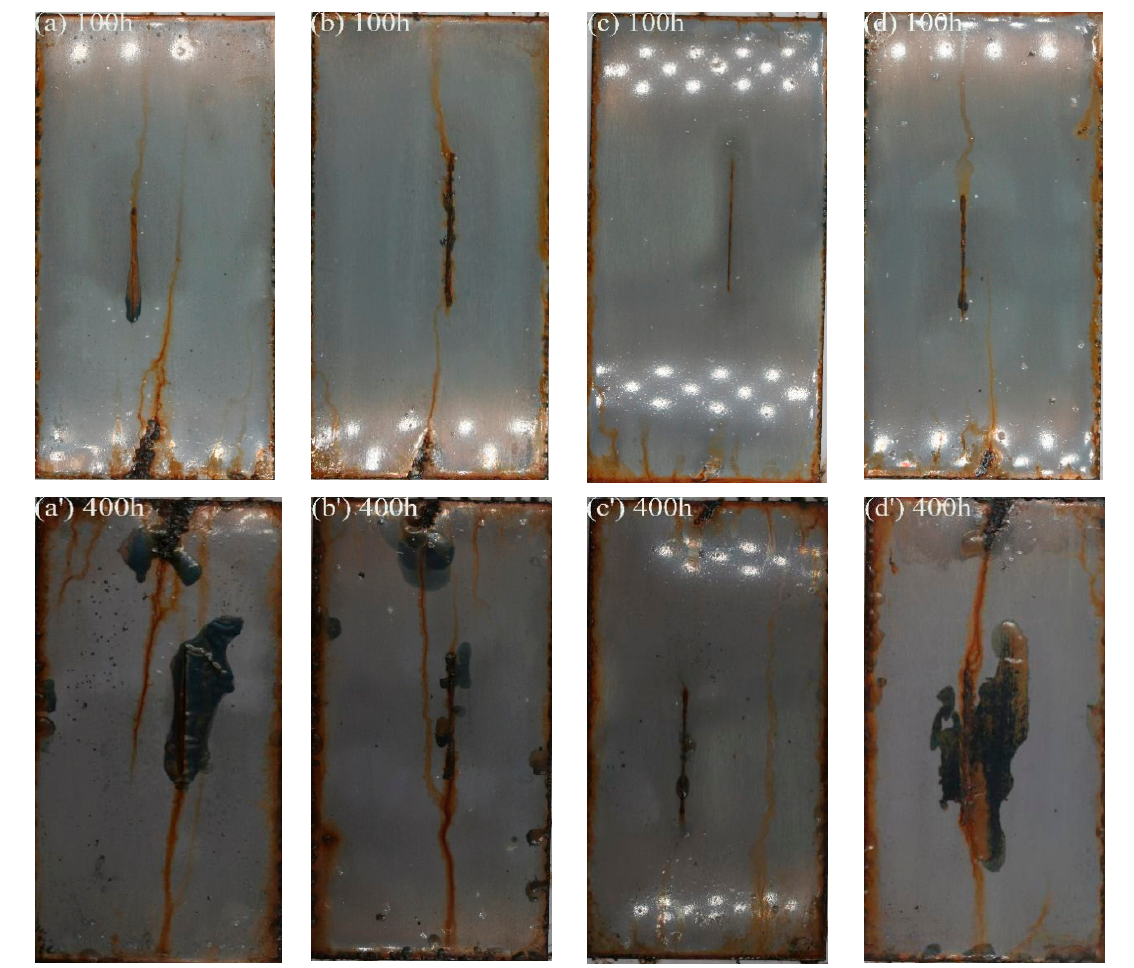
Figure 10. Corrosive-surface images of the spray test exposed for 100 and 400 h in 5 wt.% NaCl solution. ( a , a' ) Pure EP coating; ( b , b' ) 0.1%, ( c , c' ) 0.3%, and ( d , d' ) 0.6% EP/TPG.